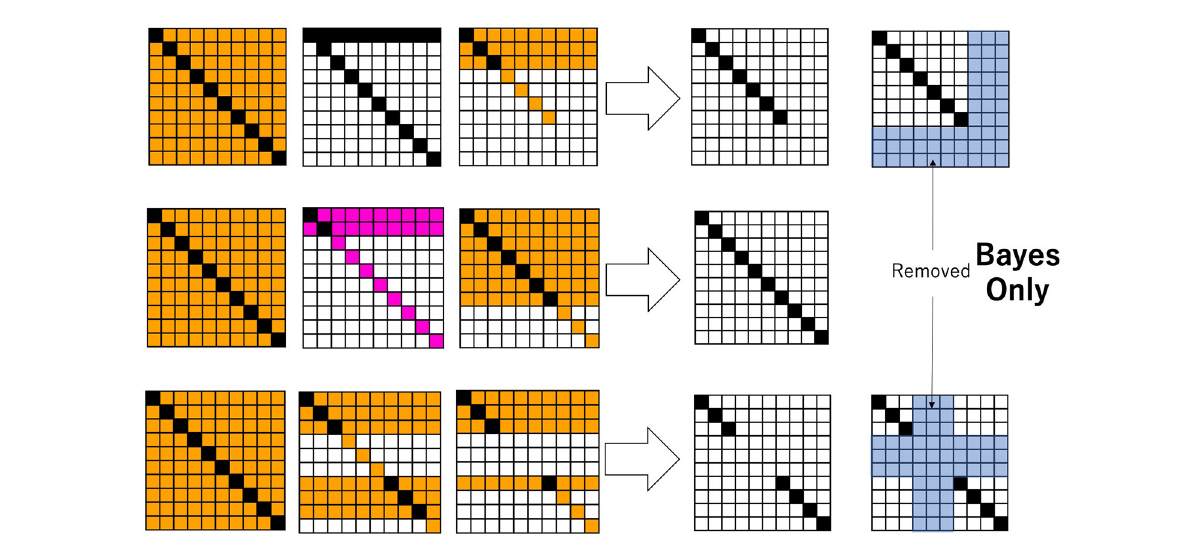
FIGURE2 Snapshots of the joint probability between data and hypotheses. The probabilities are colored from low to high in the order of white, pale yellow, orange, pink, and black. By following the thick arrow, the binary relation R is obtained. The pale blue cells represent the domain in the relation, which is ignored by Bayesian